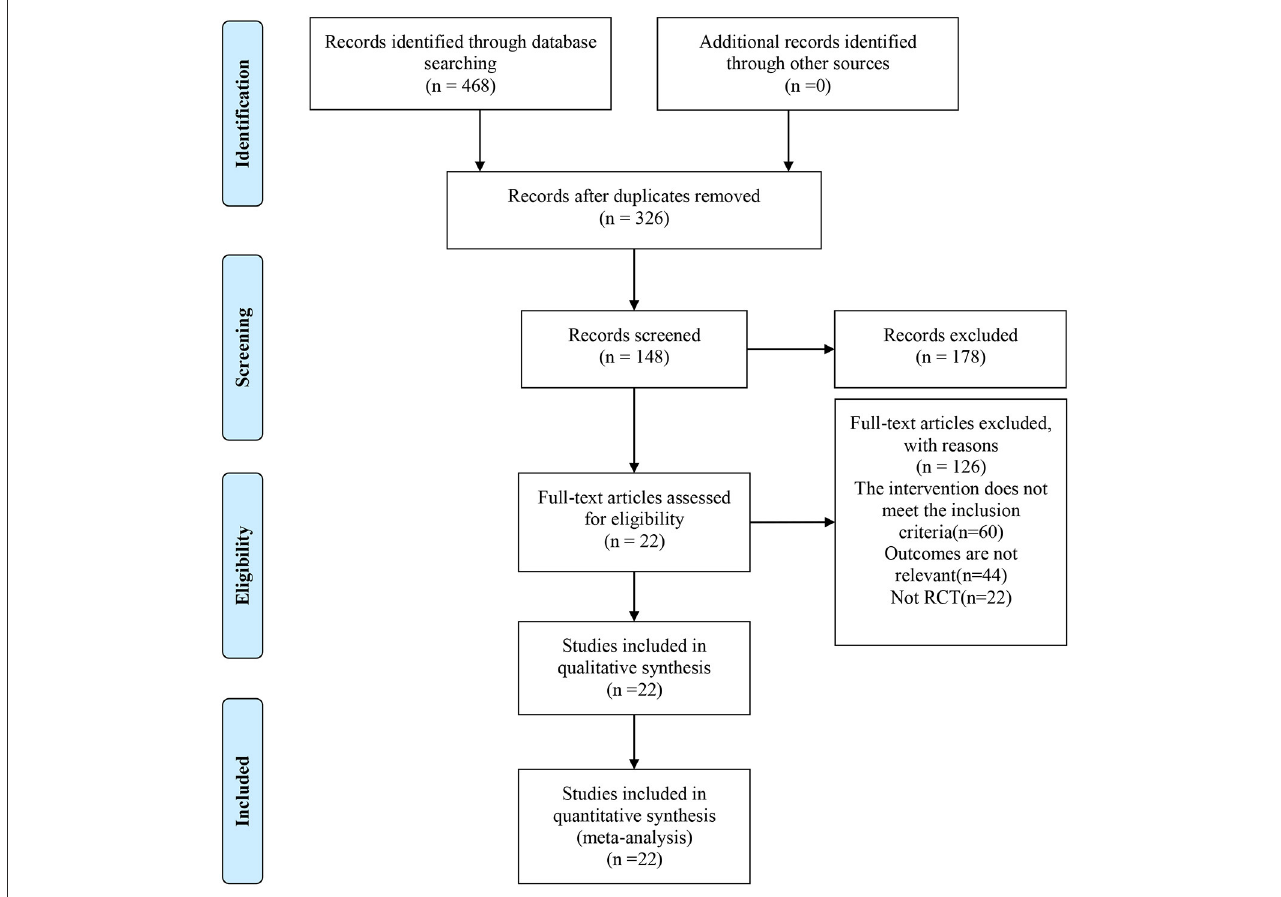
FIGURE1 Flow diagram for article screening.